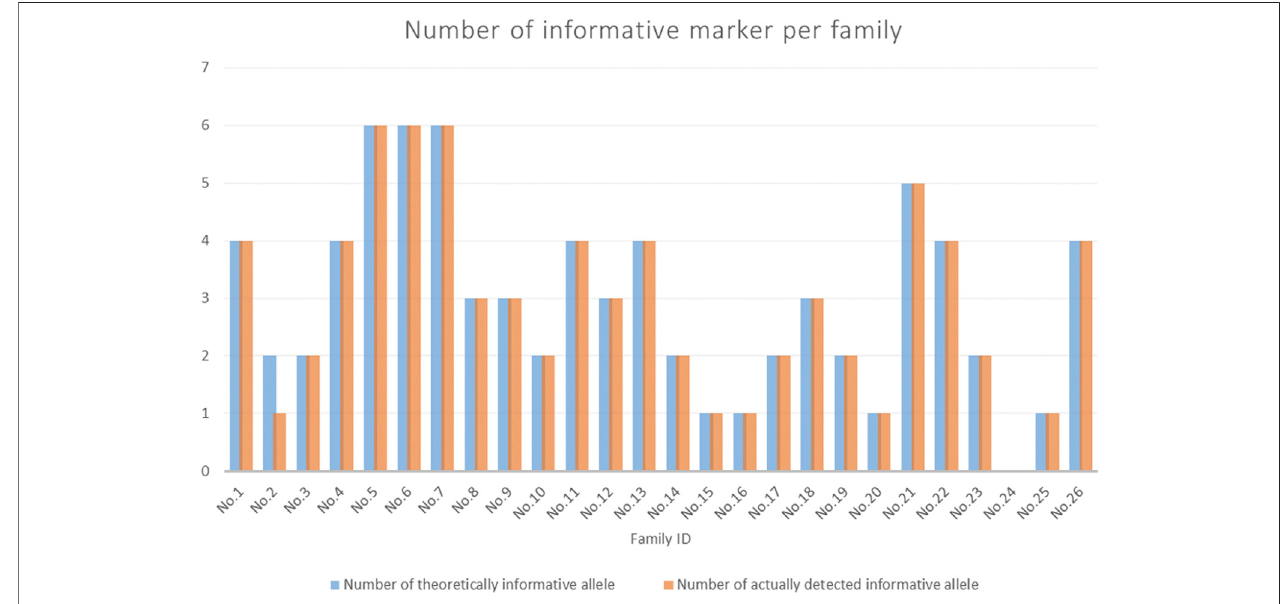
FIGURE 5 | The number of informative markers for each family. The blue bars showed the theoretical number of informative markers (expected). The orange bars indicated the actual number of informative markers detected (observed).